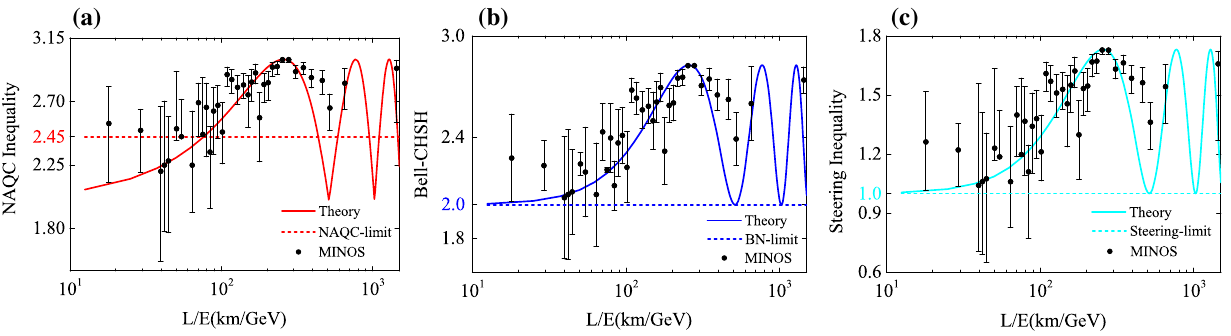
Fig. 5 NAQC inequality in Eq. (9), Bell-CHSH inequality in Eq. (11) and steering inequality in Eq. (13) in theory and experiment with error bars in MINOS collaboration (black, circle ) as a function of the ratio L / E for the initial muon flavor state. The red line (solid), the blue line